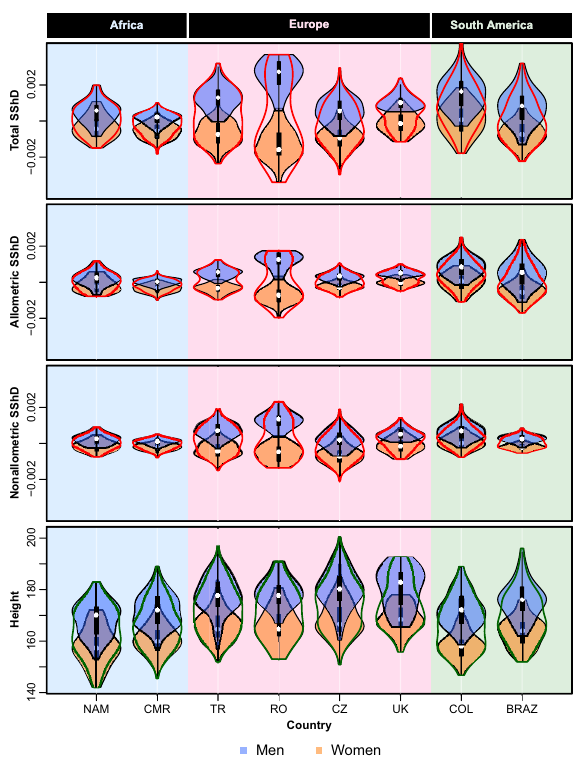
Figure 1. Violin plots showing range and variation in sexual shape dimorphism (SShD; overall, allometric, and non-allometric) and body height across eight populations (NAM-Namibia, CMR-Cameroon, TR-Turkey, RO-Romania, CZ-Czechia, UK-United Kingdom, COL-Colombia, BRAZ-Brazil). White points indicate medians, black rectangles represent interquartile ranges.